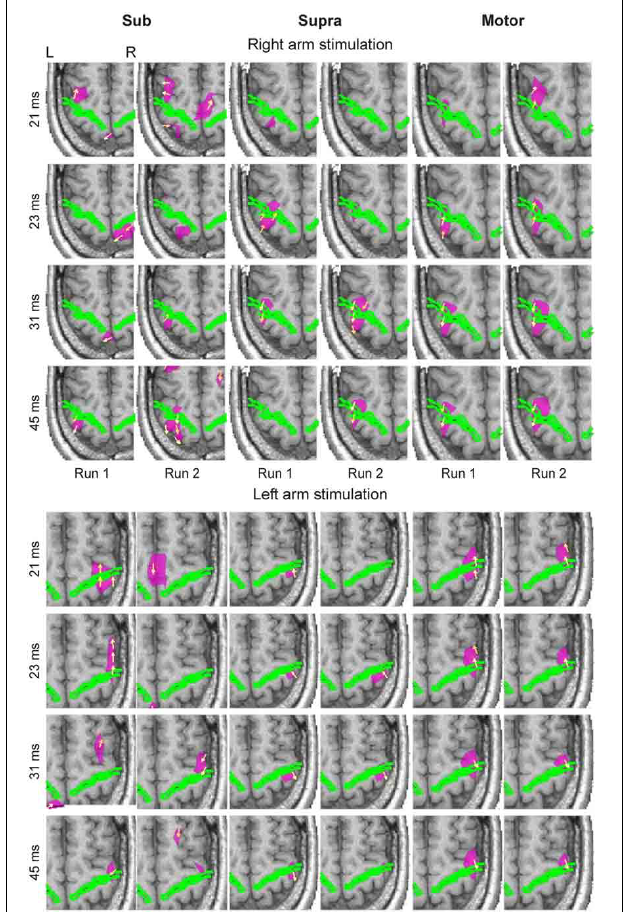
FIGURE 1 | Averaged spatio-temporal CDV-maps of the blind subject are shown for both runs of Sub (columns 1 and 2), Supra (columns 3 and 4) and Motor (columns 5 and 6) intensities at four latencies (indicated at the left side of each row) in response to right (upper block) and left (lower block) arm stimulations. The axial slice of MRI best covering the activated part of central sulcus, indicated by a green outline, is shown. Yellow arrows show the direction of CDV. Pink contours encompass regions where the normalized magnitude of CDV is above 0.9. For display purposes the CDV magnitudes were normalized independently for each image. This made all the activations clearly visible. L, left; R,